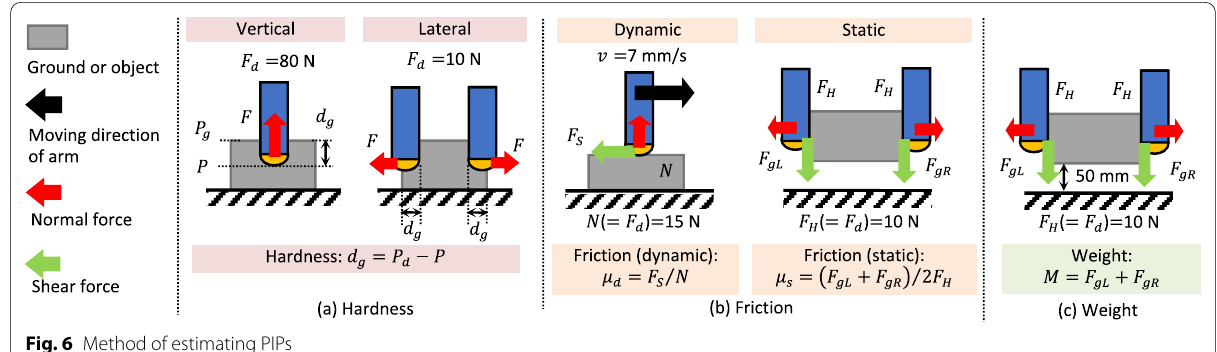
Fig. 6 Method of estimating